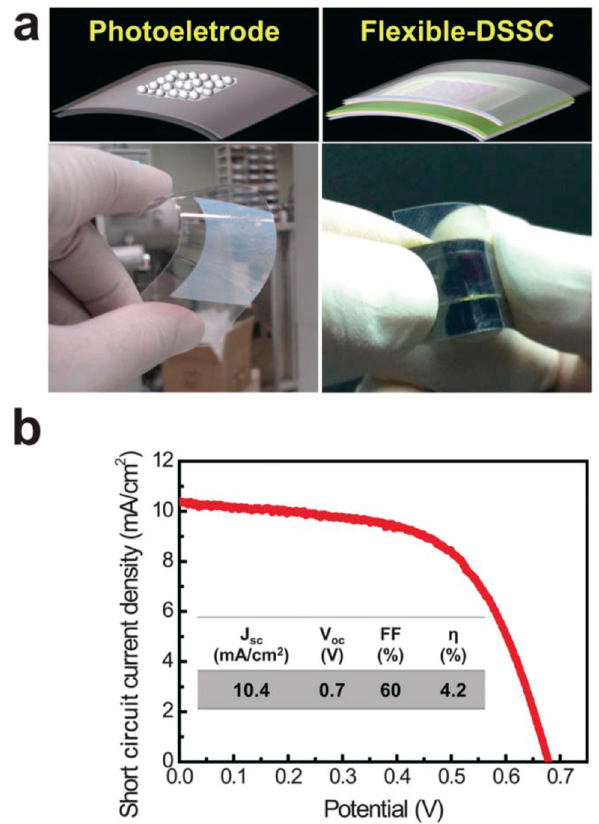
Figure 1. Flexible photoelectrode and DSSC fabricated by the APP process. ( a ) Schematic illustrations and real photo images of the flexible TiO 2 photoelectrode and DSSC based on a tin-doped indium oxide (In 2 O 3 :Sn)-coated polyethylene naphthalate substrate. ( b ) Current density–voltage characteristics of the flexible DSSC under 1 sun illumination. The photovoltaic properties (J SC —the short-circuit current density, V OC —the open circuit voltage, FF—the fill factor, and η —energy conversion e ffi ciency) of the flexible DSSC with a TiO 2 film thickness of 3 µ m are summarized in the inset of ( b ). Republished with the permission of the Royal Society of Chemistry, from [22]; permission conveyed through Copyright Clearance Center, Inc.